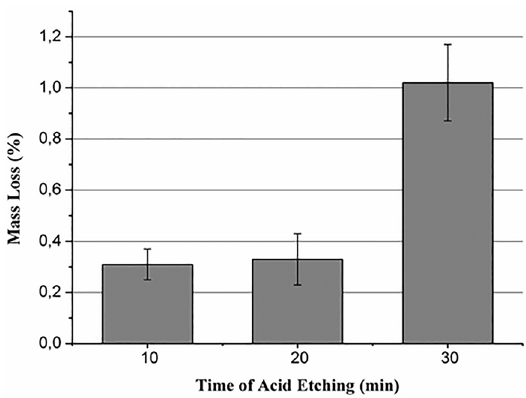
Figure 2. Mass loss of 5052 aluminum alloy in HCl (2M) solution at different acid etching